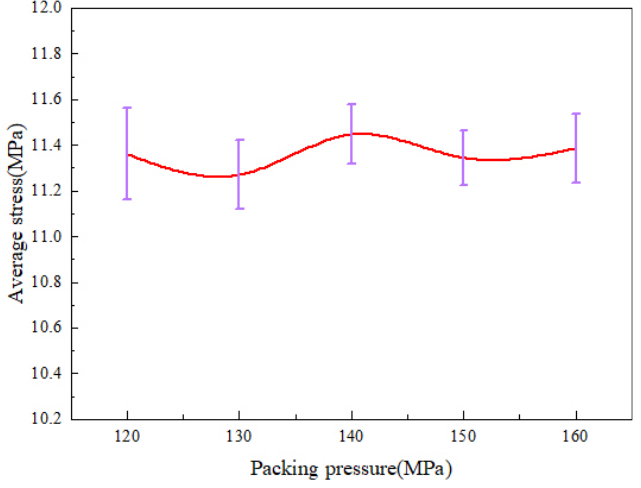
Figure 13. Average stress variations at different packing pressures along the centerline of the parts.